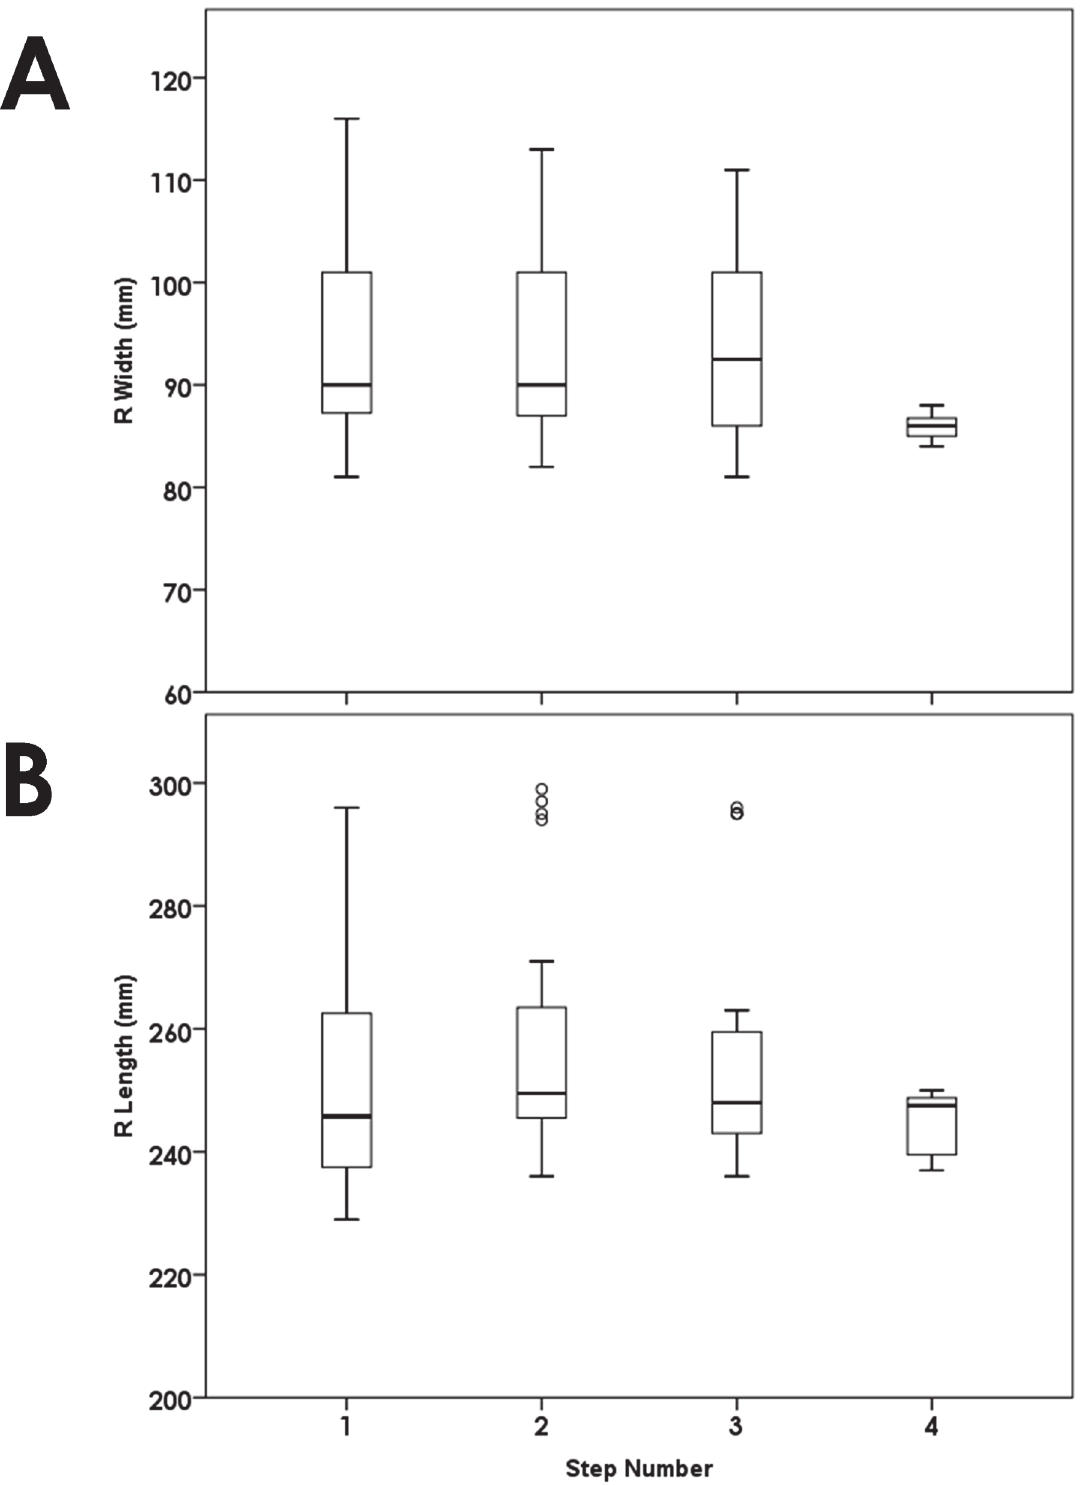
Fig 1. There was no influence of changes in paint amount or consistency across each trial: between step width and step number, p = 0.328; between step length and step number, p = 0.959.